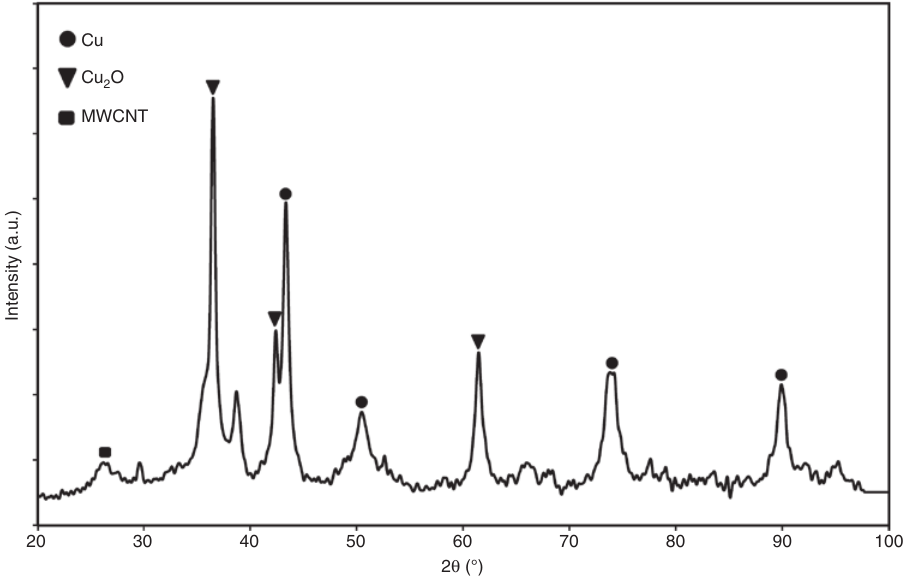
Figure 4: XRD pattern of coated